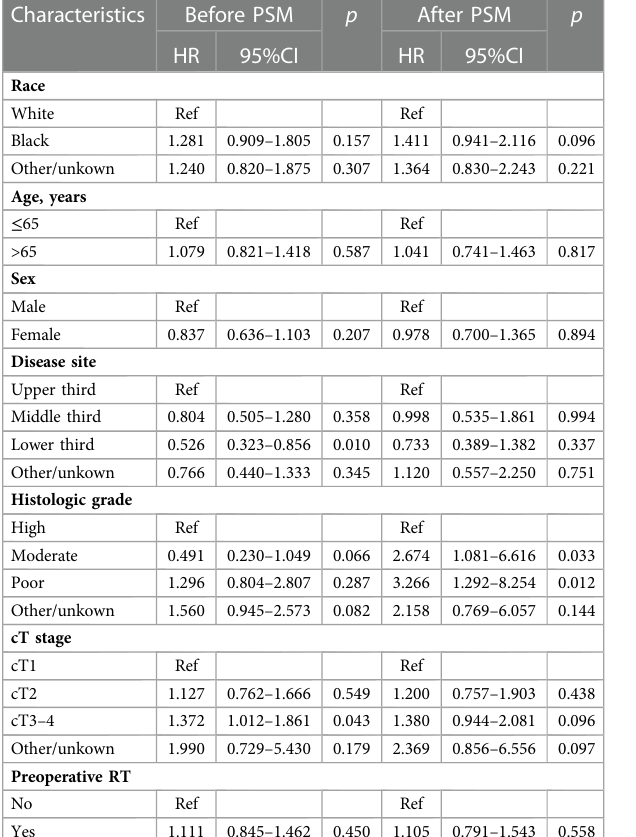
TABLE 4 Univariable and multivariable cox analysis of the in fl uence of each characteristic on overall survival for cT1-2 patients after propensity score